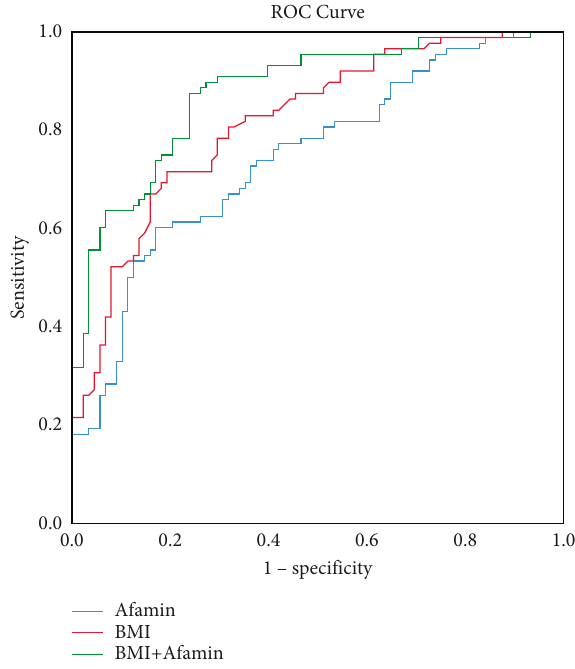
Figure 2: Receiver operating characteristic (ROC) analysis for the diagnosis of NAFLD. The ROC curves for afamin, BMI, and afamin plus the BMI are shown. The area under the curve (AUC) of afamin was 0.746, and the positive predictive value was 62.5%. The negative predictive value was 69.3%, and the accuracy was 65.9%. The area under the curve (AUC) of the BMI was 0.818, and the positive predictive value was 77.3%. The negative predictive value was 70.5%, and the accuracy was 73.9%. The area under the curve (AUC) of afamin plus the BMI was 0.878, and the positive pre- dictive value was 77.3%. The negative predictive value was 79.5%, and the accuracy was 78.4%.